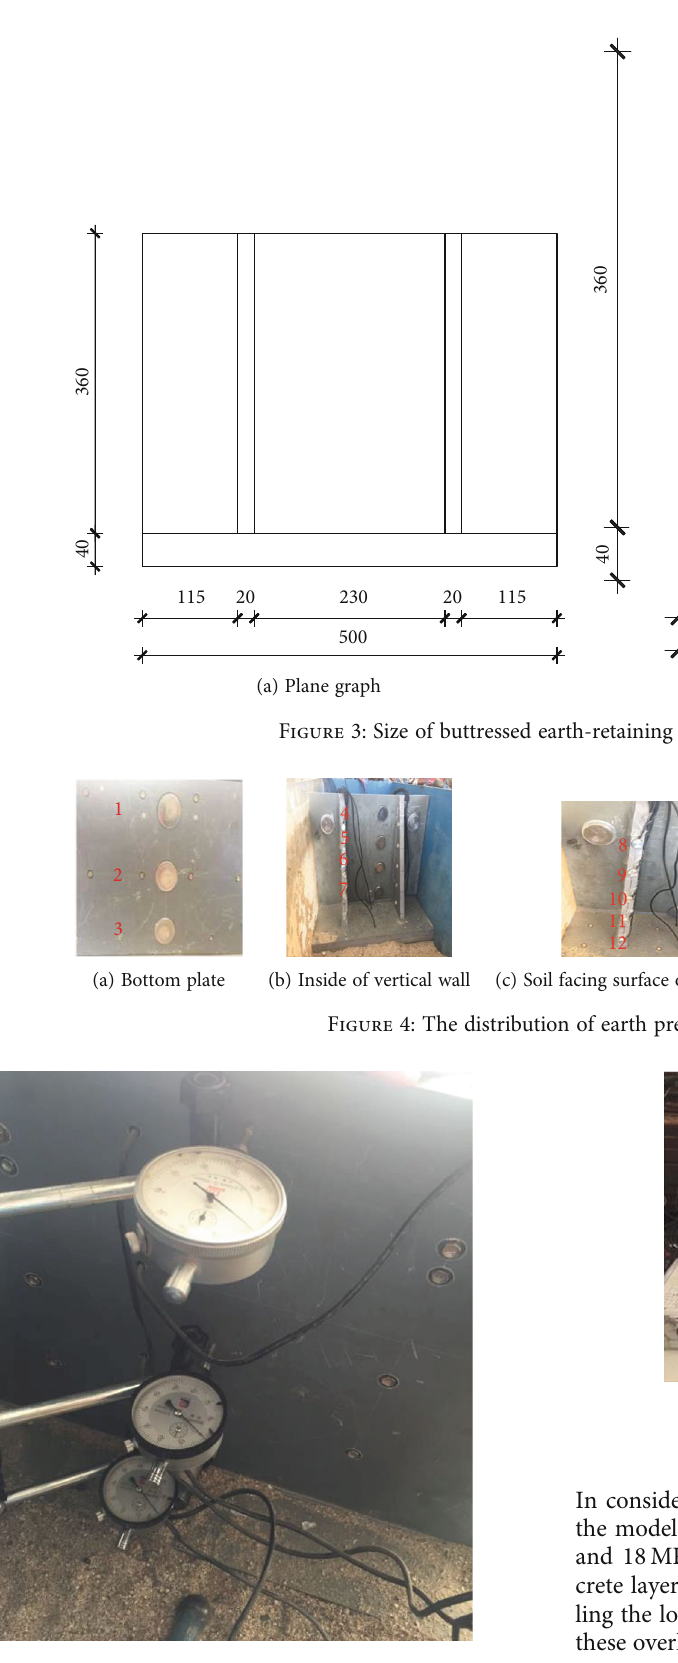
Figure 5: The distribution of dial indicators.